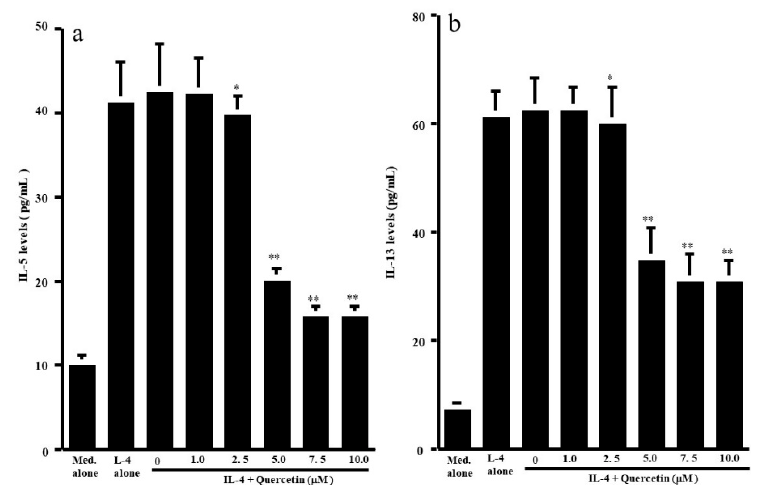
Figure 1. Influence of quercetin on Th2-type cytokine production from human peripheral-blood CD4 + T cells in vitro. CD4 + T cells (1 × 10 6 cells/mL) were stimulated with 10.0 ng/mL IL-4 in the presence of various concentrations of quercetin for 24 h. Cytokine levels in culture supernatants were examined by ELISA. The results were expressed as the mean pg/mL ± SE of five subjects. ( a ): IL-5; ( b ): IL-13; * p > 0.05 versus IL-4 alone; ** p < 0.05 versus IL-4 alone.